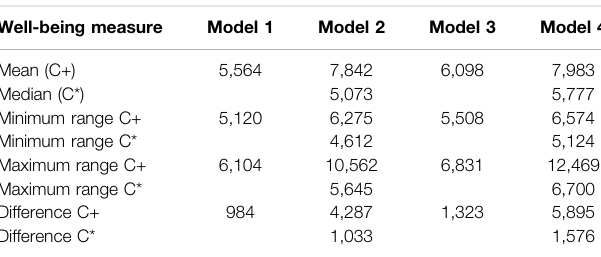
TABLE 5 | WTP for cubic meters of dry